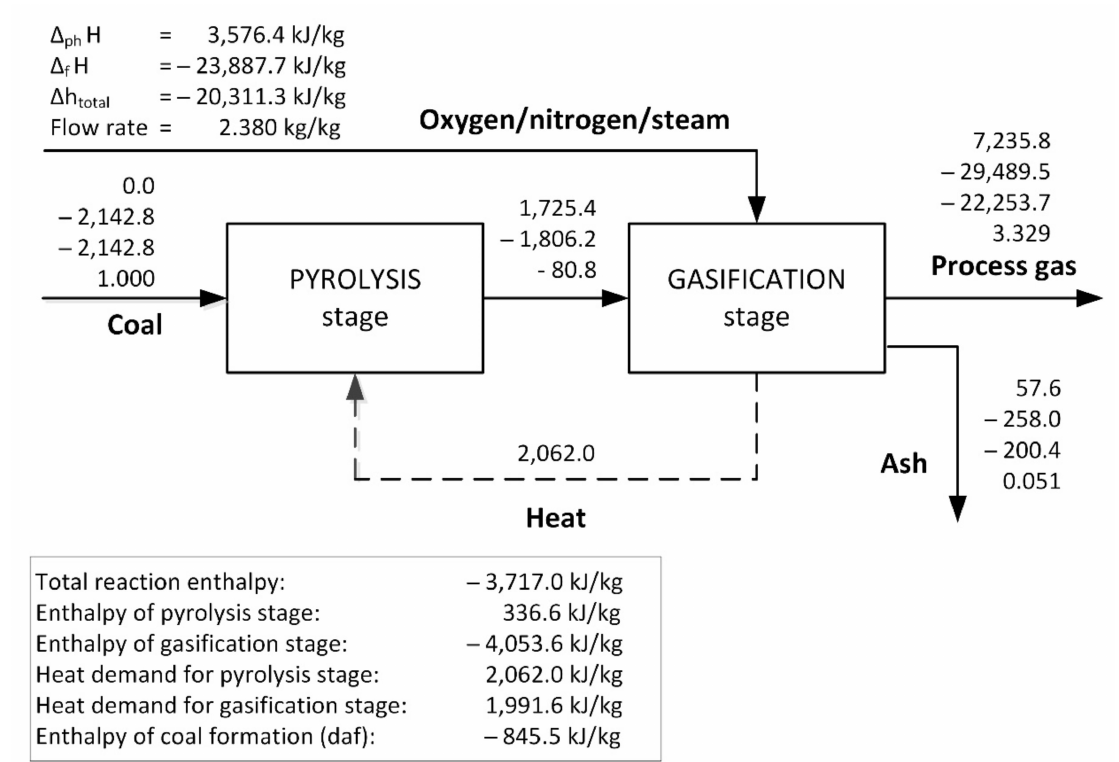
Figure 15. Energy balance of SES process for subbituminous coal gasification per 1 kg of feed